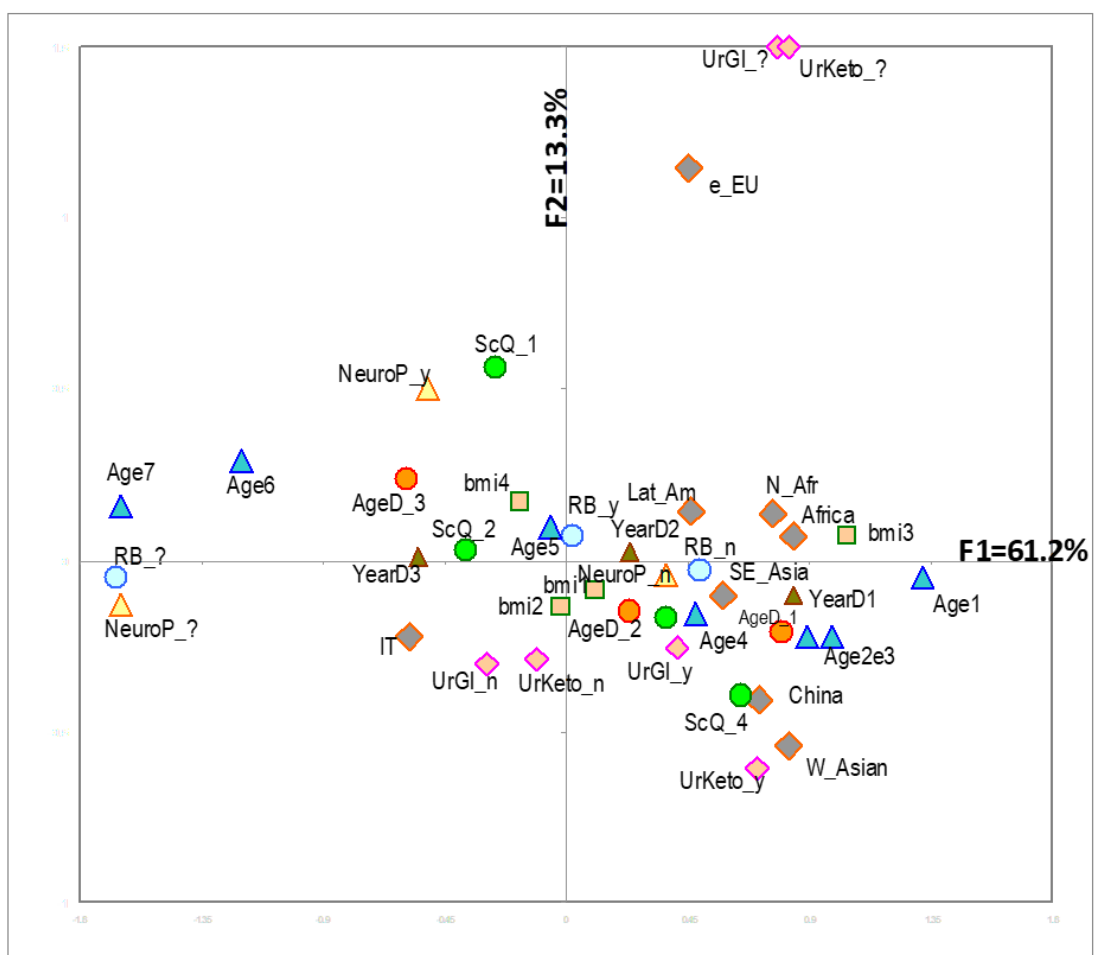
Figure 1. Graphic representation of the first factorial MCA plane. The variables with the greatest contribution to factorial axes are shown, together with the passive variable ethnicity. Abbreviations: Bmi: Body Mass Index; CVD: Cardiovascular Disease; FamD: Family history of Diabetes; NephP: Nephropathy; NeurP: Neuropathy; RB: Risk behaviors; RFCV: Risk factors for cardiovascular diseases; RetP: Retinopathy; ScQ: Score Q; UrGl: Glycosuria; UrKeto: Ketonuria.